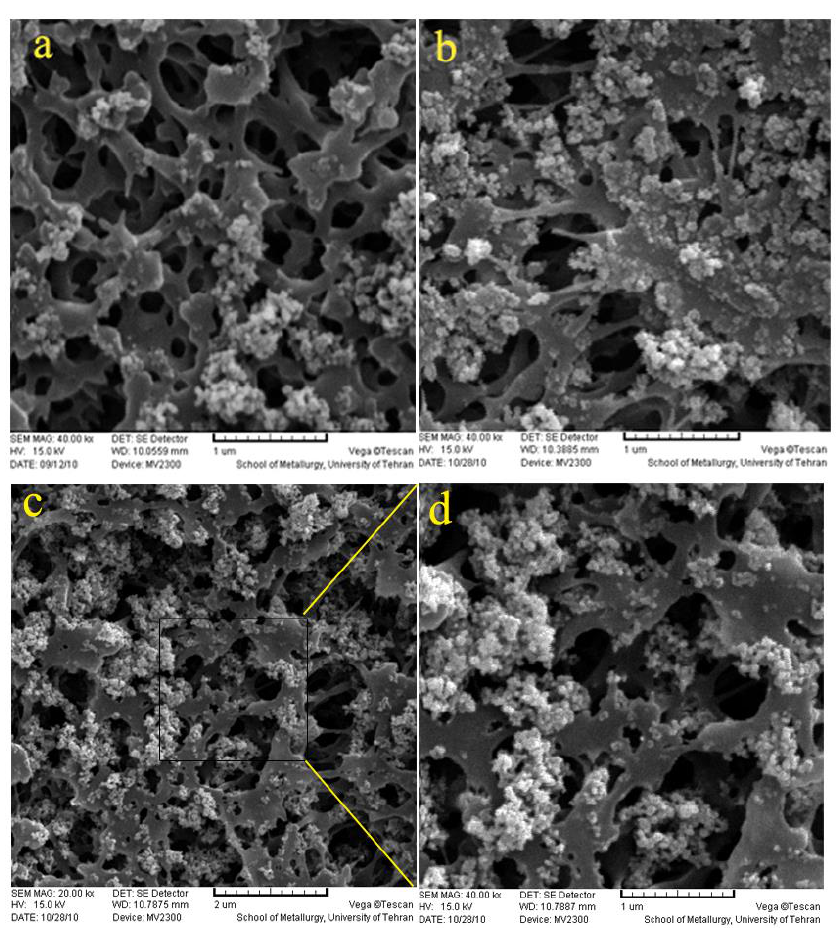
Figure 2. The SEM image of ( a ). PPM1 / TiO 2 ; ( b ). PPM3 / TiO 2 ( c , d ): PPM5 / TiO 2